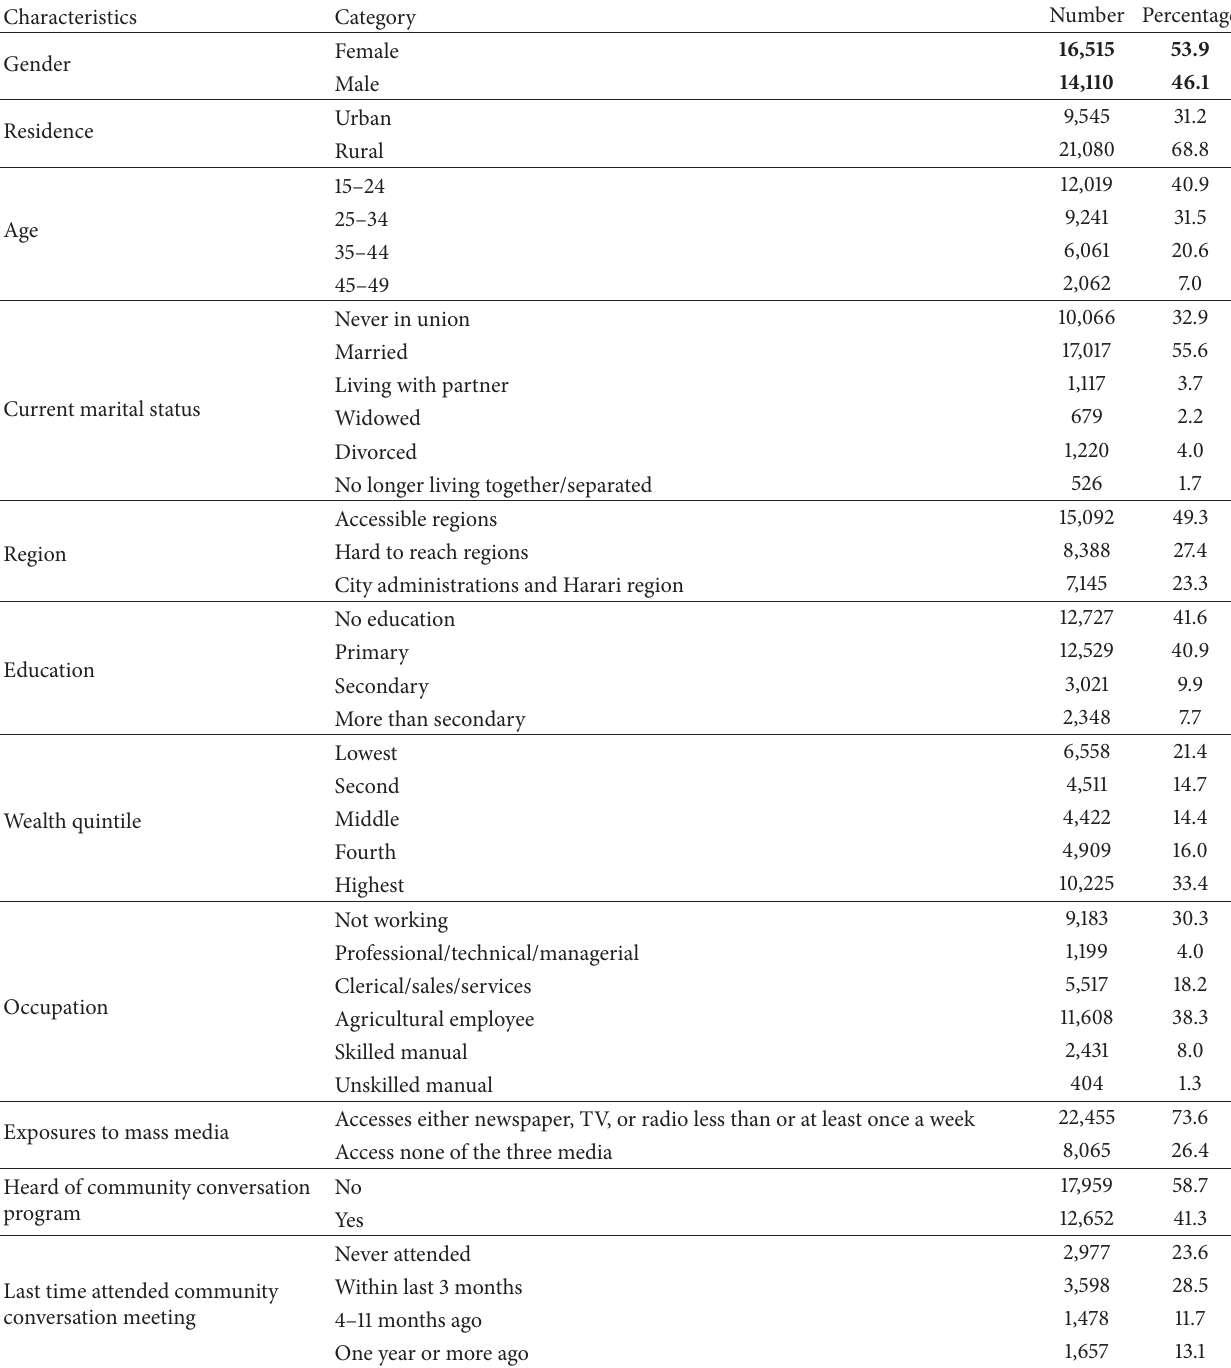
Table 1: Background characteristics of respondents, Ethiopia